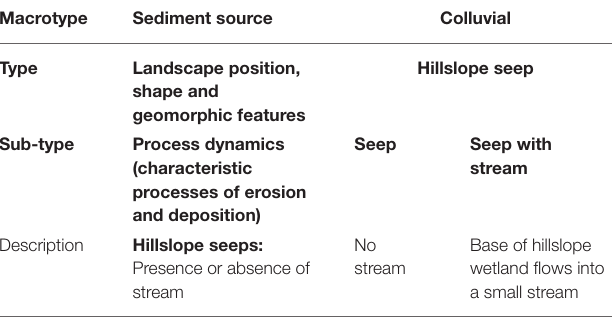
TABLE 2 | Description of hillslope seep